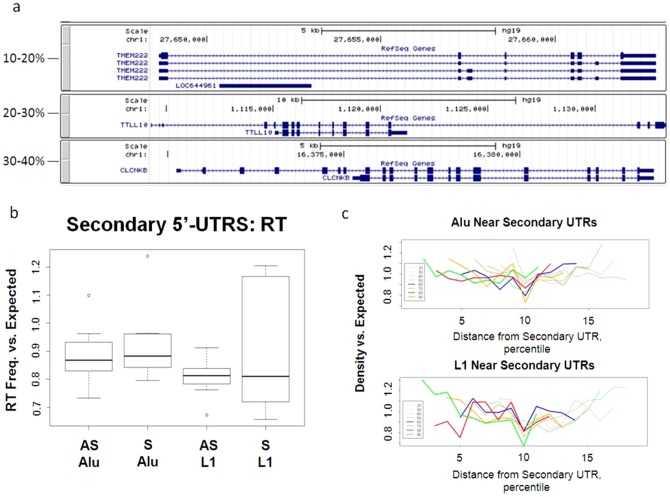
Frequency of L1 and Alu is reduced in the presence of a 5′-UTR.a) Examples of genes containing a secondary 5′-UTR within the gene boundaries. Each group shows an example of the secondary 5′-UTR occurring in a separate decile (examples shown: 1st decile: TMEM222, chr1: 27648636–27662891, 2nd decile: TTLL10, chr1: 1109286–1133313, and 3rd decile: CLCNKB, chr1: 16370231–16383821). Screenshots were taken from UCSC Genome Browser (Hg19). b) Frequencies of Alu and L1 were then calculated within each decile of the aforementioned genes. These values were compared to expectation based on the calculations in the respective decile across all genes. Student's t-test p<2.99 E-06L1 AS, 0.04L1 S, 0.48Alu AS, 0.24Alu S. c) Antisense oriented Alu and L1 frequencies were calculated in all deciles for each group of genes that were separated as in figure 6a. These frequencies were compared to the expected frequencies based on overall values. Each line represents the change from expected for each gene group. The first and last deciles were excluded from analysis. 2nd decile (light blue line), 3rd decile (pink line), 4th decile (light green line), 5th decile (tan line), 6th decile (blue line), 7th decile (orange line), 8th decile (red line), 9th decile (green line).